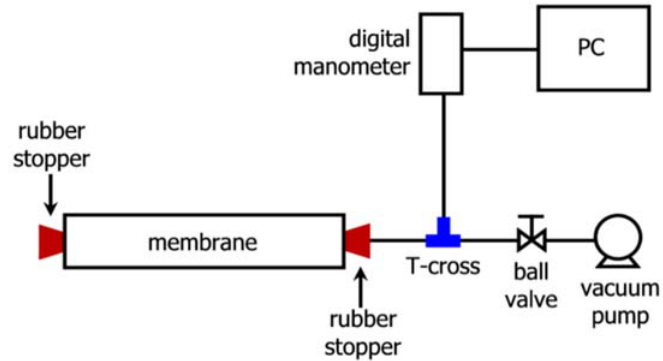
Figure 2. Schematic illustration of vacuum decay test (VDT) apparatus.